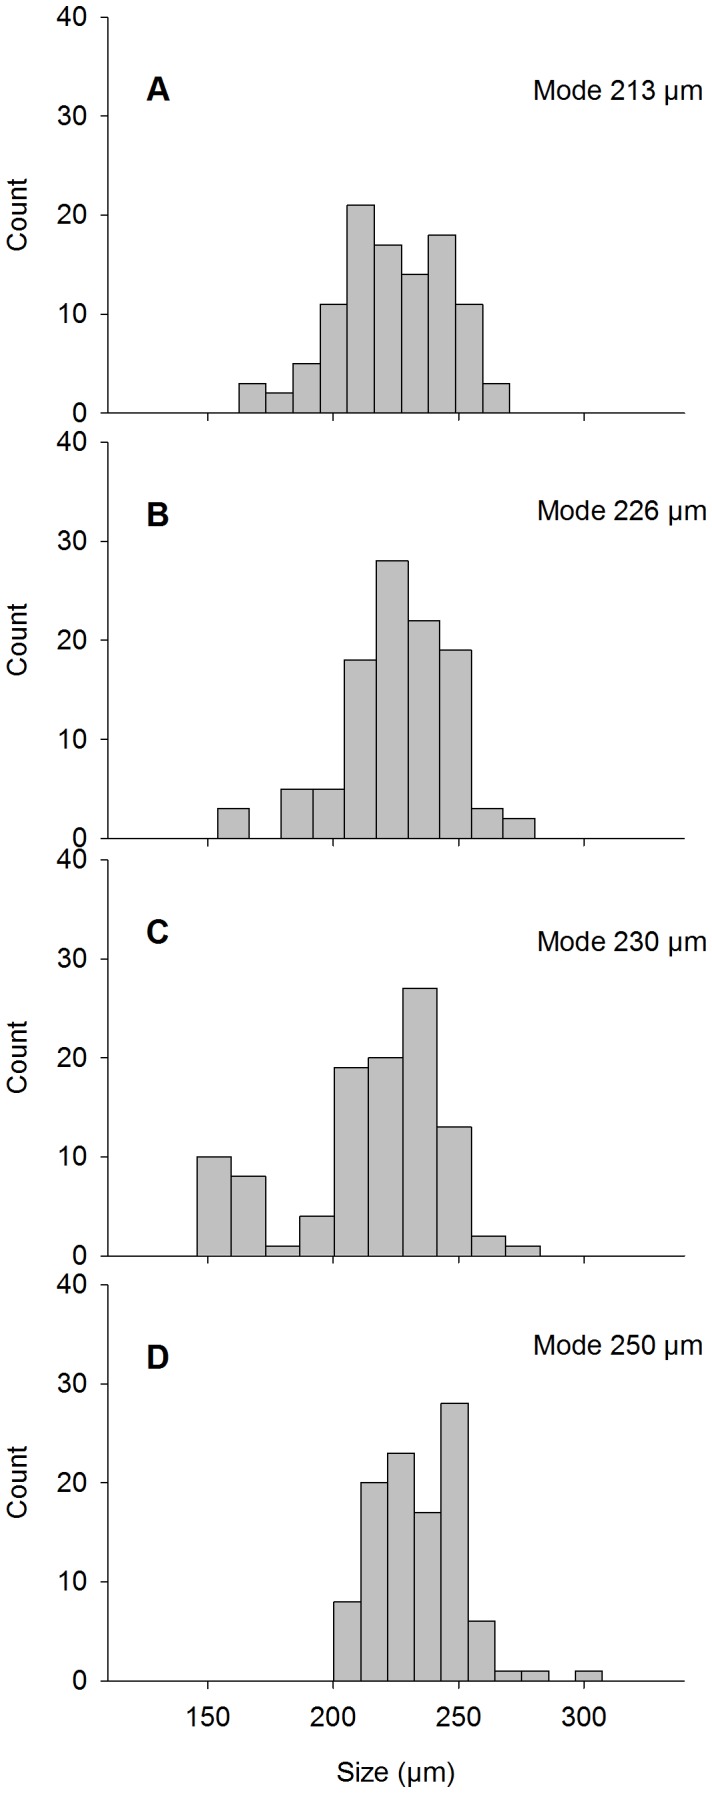
Larval sizes at the end of the 20-day experiment in different pH treatments.Larval sizes are illustrated as size frequency distributions in pH treatments (A) 7.2, (B) 7.4, (C) 7.7 and (D) 8.1, and presented with mode values illustrating the increase of large size fractions in the control treatment.